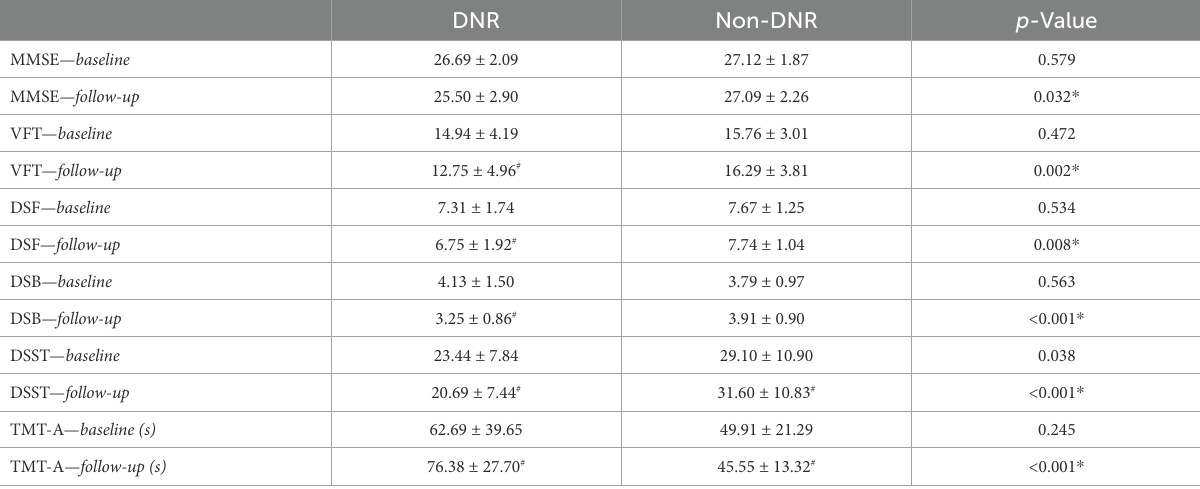
TABLE 2 Neurocognitive